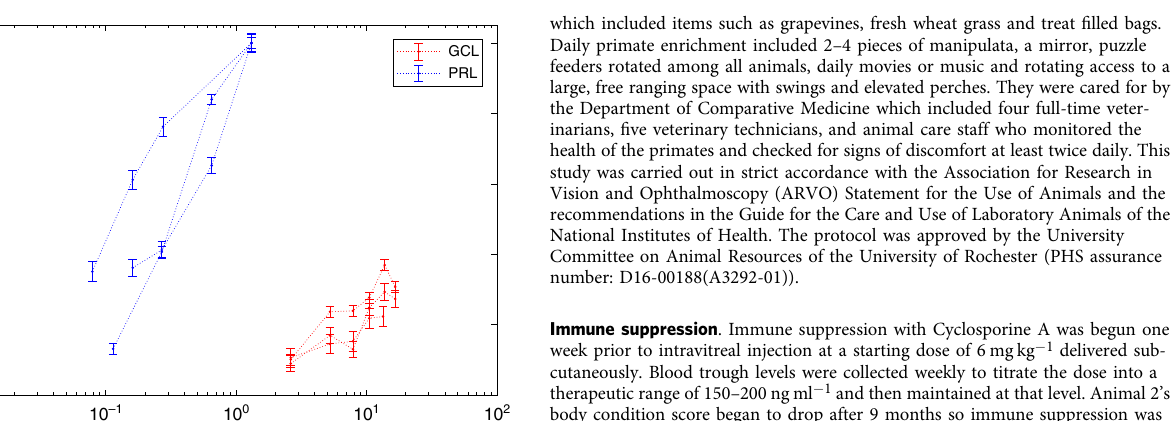
Fig. 2 Optogenetic therapy restores characteristic retinal ganglion cell responses to patterned stimuli in the living primate. a Pixelwise map of the temporal phase of ganglion cells responding to a 0.2 Hz drifting grating presented to foveal cones. b The spatial frequency of the ganglion cell layer (GCL) response to a 2.7 cycles per degree stimulus presented at the fovea. The spatial frequency of the response is lower than the spatial frequency of the stimulus because of the anatomical expansion of the ganglion cell density relative to the density of the foveal cones to which they are connected. c The